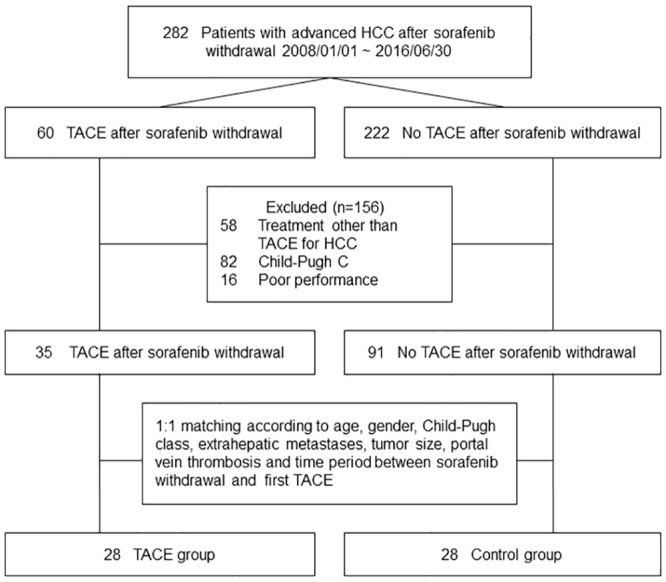
Flow algorithm of patient selection.